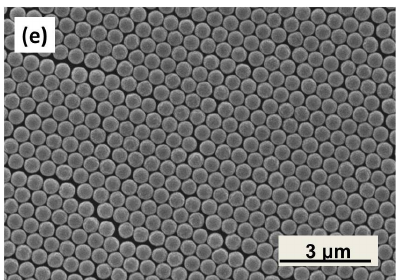
Figure 3. SEM images of the self-assembly PS nanosphere masks fabricated by different coating methods. ( a , b ) drop-coating self-assembly method; ( c , d ) spin-coating self-assembly method; ( e ) drop-coating self-assembly method in a large area.